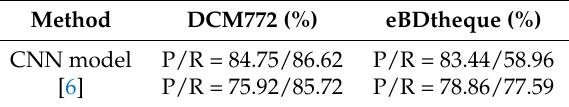
Table 9. Panel detection: A comparison between the CNN detection model with [6] on DCM772 and both datasets. Using trained CNN model, we keep only detections with a confidence score